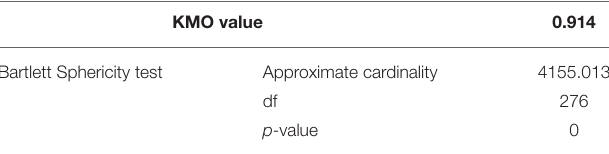
TABLE 5 | KMO and Bartlett’s